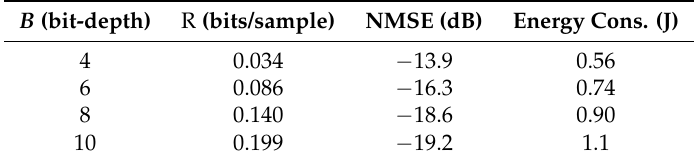
Table 1. Energy consumption of compressive sensing (CS) scheme, applied to the reconstruction of N = 512 samples of a temperature signal, using 14 CS